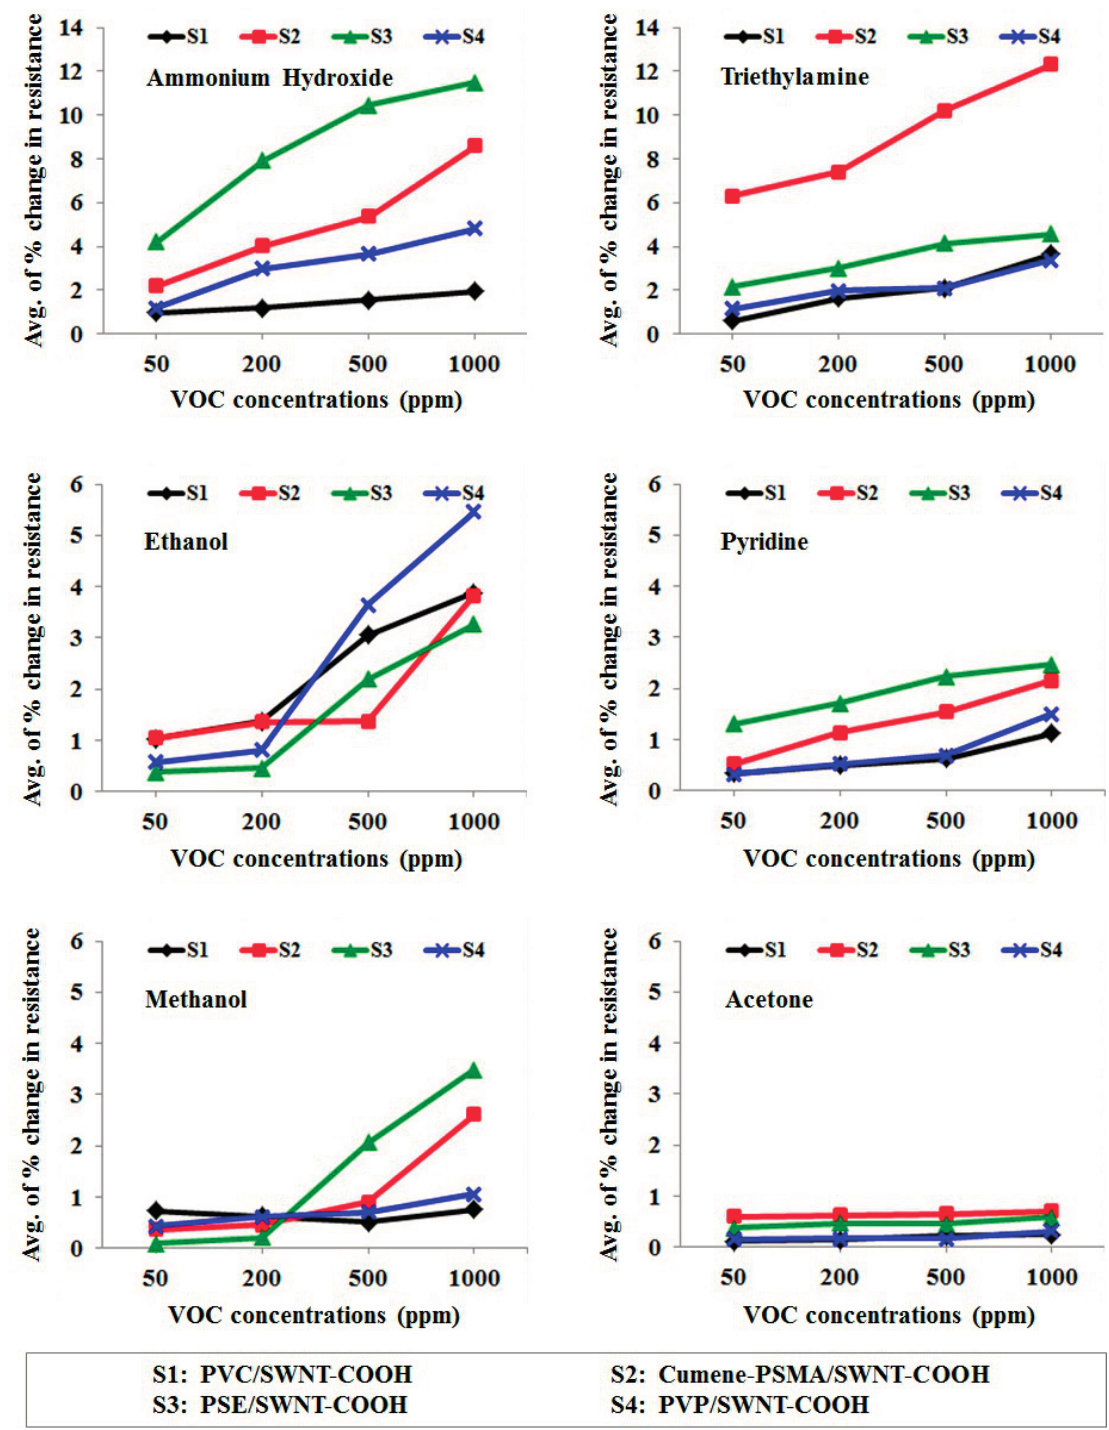
Figure 8. The average of percent change in resistance of fabric-based chemical gas sensors in the static measurement system when exposed to ammonium hydroxide, triethylamine, ethanol, pyridine, methanol and acetone at the concentrations of 50–1000 ppm. In this work, the dynamic responses of the fabric-based chemical gas sensors were recorded as a change in the resistance values. The measurement was performed by switching between the sample odor for 1 min and the purity air for 20 min. This process was repeated for four cycles. The graph of the fabric-based chemical gas sensing signal (sensogram) from four sensors is shown in Figure 9.